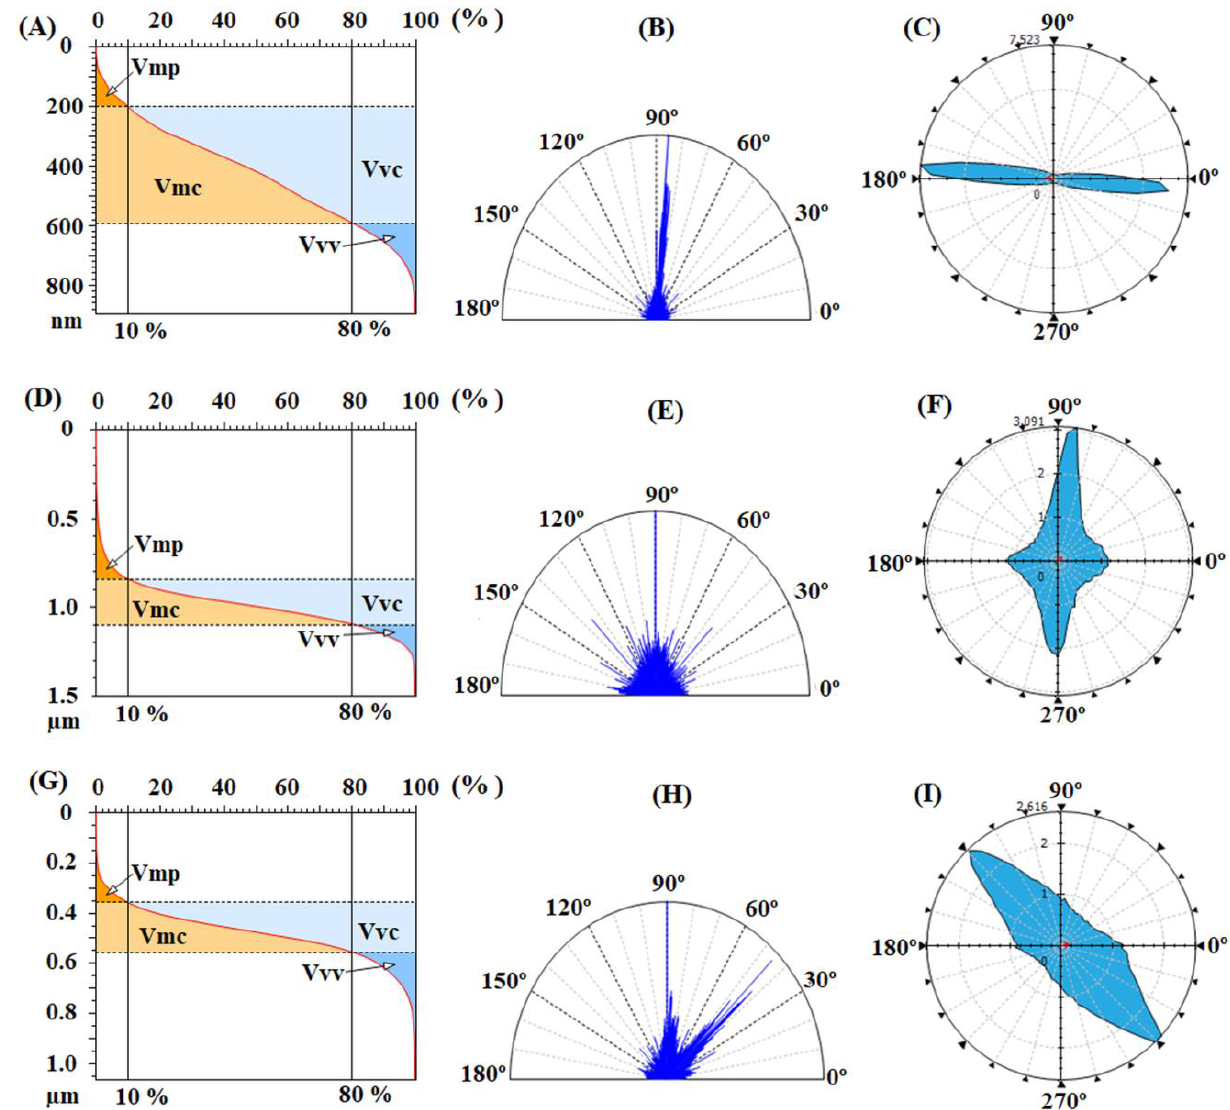
Figure 7. Abbott–Firestone curves with functional volume parameters, texture direction represen- tations and graphs with polar coordinates to analyze orientation with azimuth angle obtained for rubbed EPI-pBAPS (1R) ( A – C ), EPI-pBAPS (2R) ( D – F ) and EPI-pBAPS (3R) ( G – I ) samples.